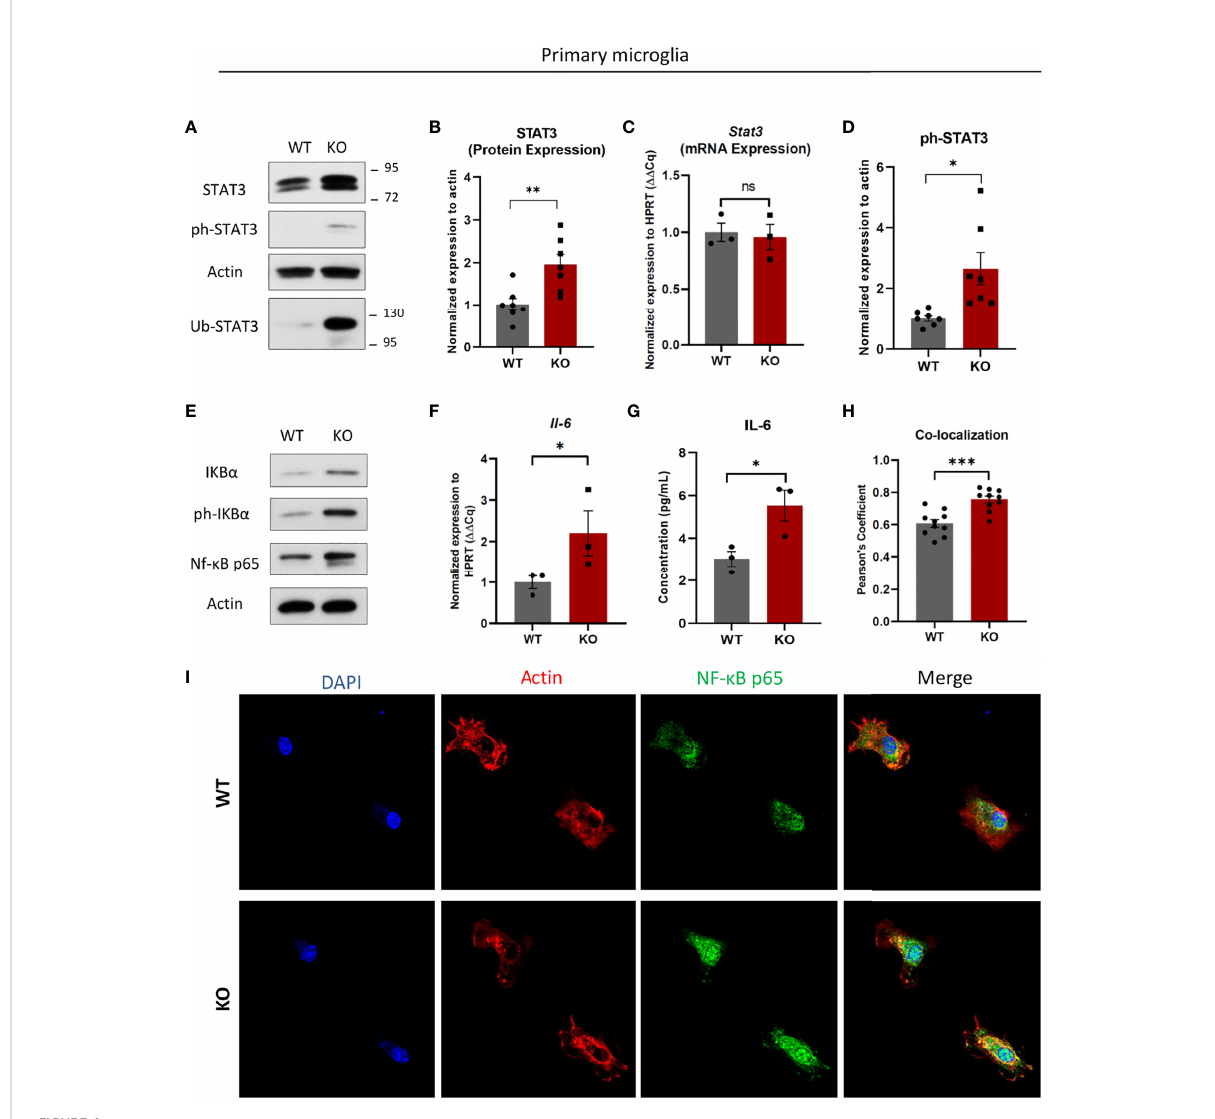
FIGURE 4 Immunoproteasome de fi ciency results in accumulation of signal transducer and activator of transcription 3 (STAT3) and increase of nuclear factor-kappa B (NF- k B) pathway proteins in primary murine microglia. (A) Western blot analysis of signal transducer and activator of transcription 3 (STAT3) in WT and b 5i/LMP7 KO primary murine microglia. (B) Quanti fi cation analysis of STAT3 Western blot data from fi gure 4A (n=7). (C) Quantitative reverse transcription PCR (RT-PCR) analysis of Stat3 mRNA level in WT and b 5i/LMP7 KO microglia (n=3). (D) Quanti fi cation analysis of ph-STAT3 Western blot data from fi gure 4A (n=7). (E) Western blot analysis of nuclear factor-kappa B (NF- k B) pathway proteins inhibitor kappa B (I k B), phosphoylatated I k B and NF- k B p65 (n=4). (F) Quantitative reverse transcription PCR (RT-PCR) analysis of interleukin-6 (Il-6) mRNA level in WT and b 5i/LMP7 KO microglia (n=3). (G) Quantitative analysis of secreted interleukin-6 (IL-6) protein level in WT and b 5i/LMP7 KO microglia as indicated by ELISA analysis (n=3). (H) Co-localization analysis of NF- k B and nuclear staining shown by Pearson ’ s Coef fi cient correlations in WT and b 5i/LMP7 KO microglia (n=10). (I) Confocal fl uorescence microscopy analysis of NF- k B p65 (AlexaFluor 488, Green) in nucleus (DAPI, blue) and cytosol (Actin, red) in WT and b 5i/LMP7 KO microglia. Mean ± SEM; *: P < 0.05, **: P < 0.01, ***: P < 0.001. ns, not signi fi